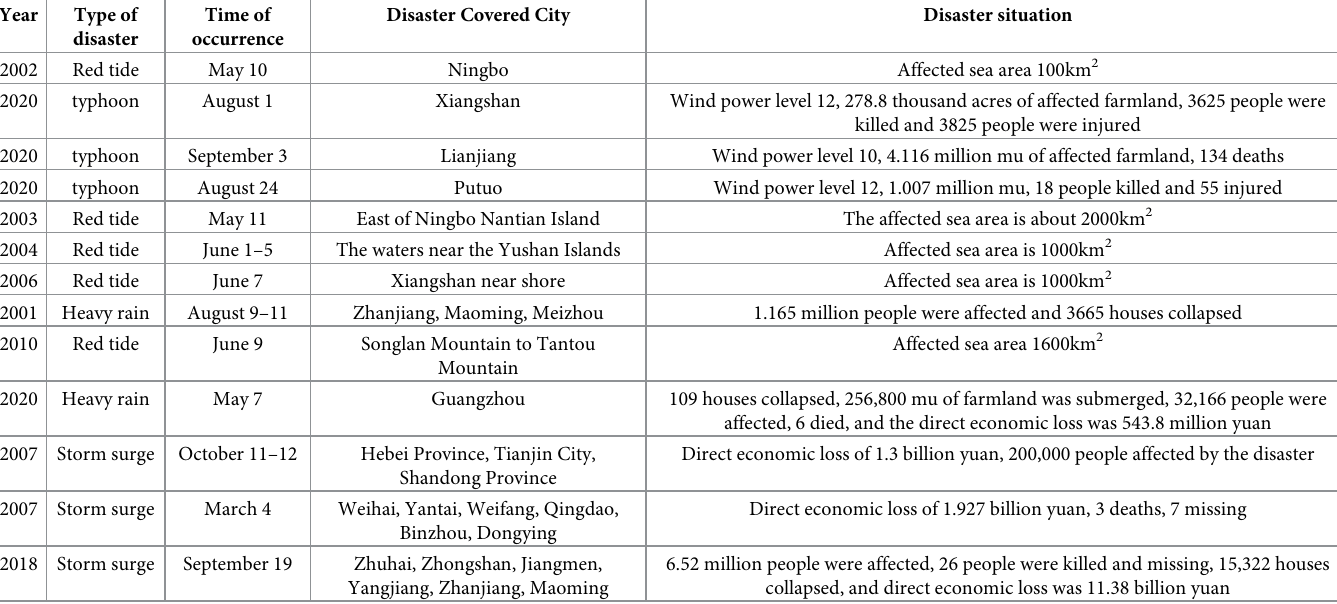
Table 3. 13 disaster events in coastal cities of China in the past 20